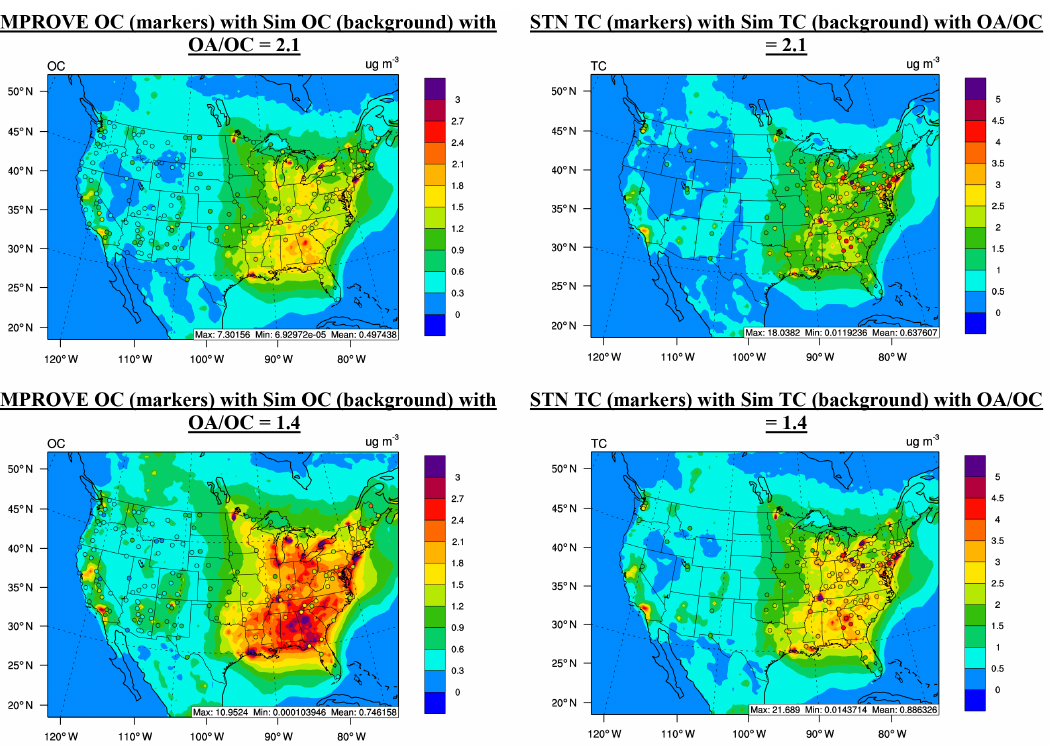
Figure 2. Overlay of obs data (markers) vs. sim data (background) for IMPROVE OC and STN TC and for OA / OC ratios of 1.4 and 2.1 for the case